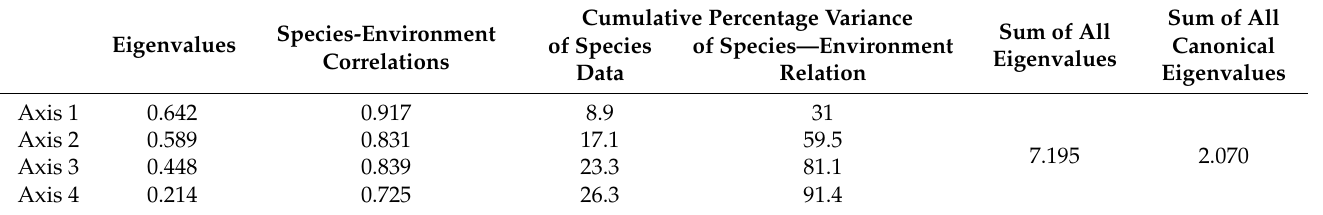
Table 3. CCA ordination